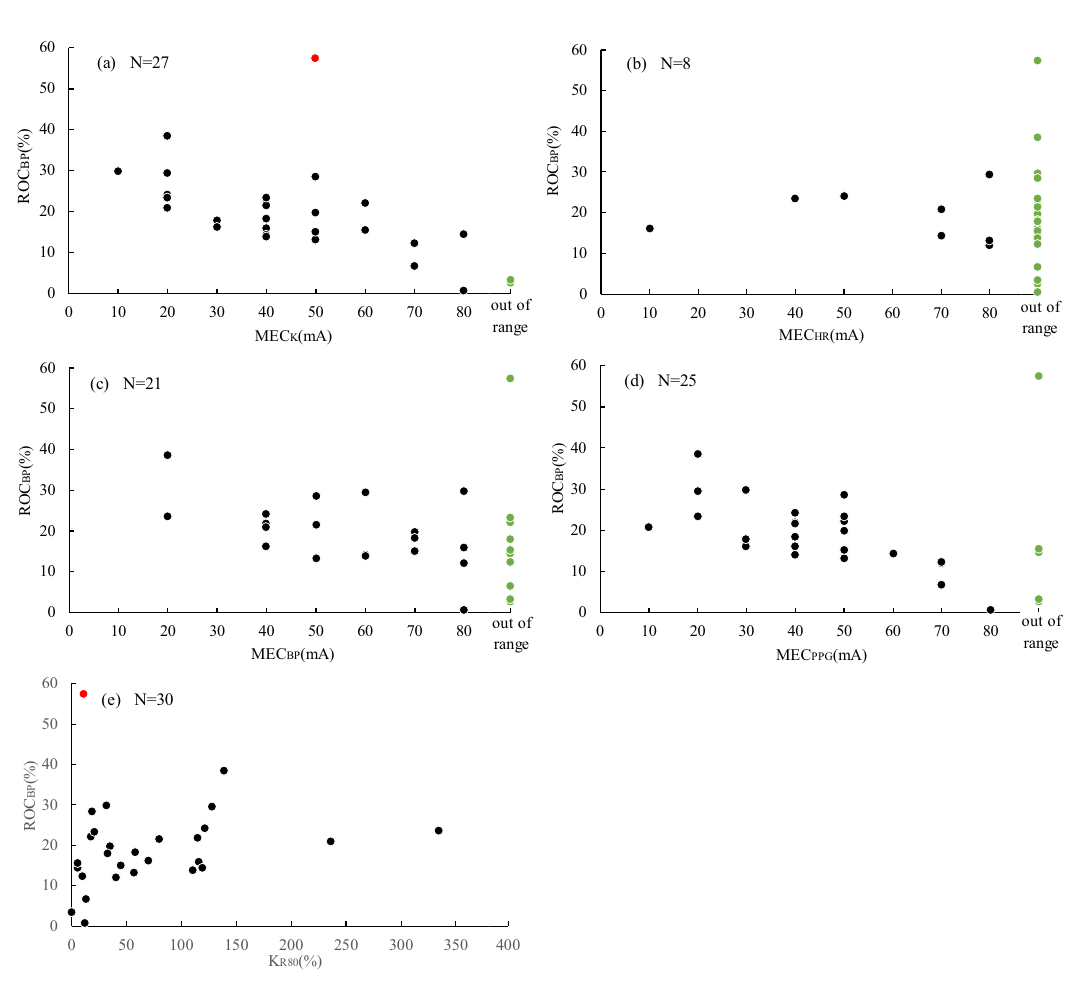
Figure 5. Relationship between minimum evoked current (MEC) + rate of change in K for 80 mA tetanus stimulation (K R80 ) and rate of change of systolic blood pressure (ROC BP ). A scatter plot of each minimum evoked current (MEC), vascular stiffness value (K), systolic blood pressure (sBP), heart rate (HR), photoplethysmography amplitude (PPG), and rate of change of systolic blood pressure (ROC BP ) is shown. Out-of-range cases are shown using green points, and Smirnoff-Grubbs test outlier points are shown in red. A downward rightward trend is observed for MEC K , MEC BP , and MEC PPG , and an upward rightward trend is observed for K R80